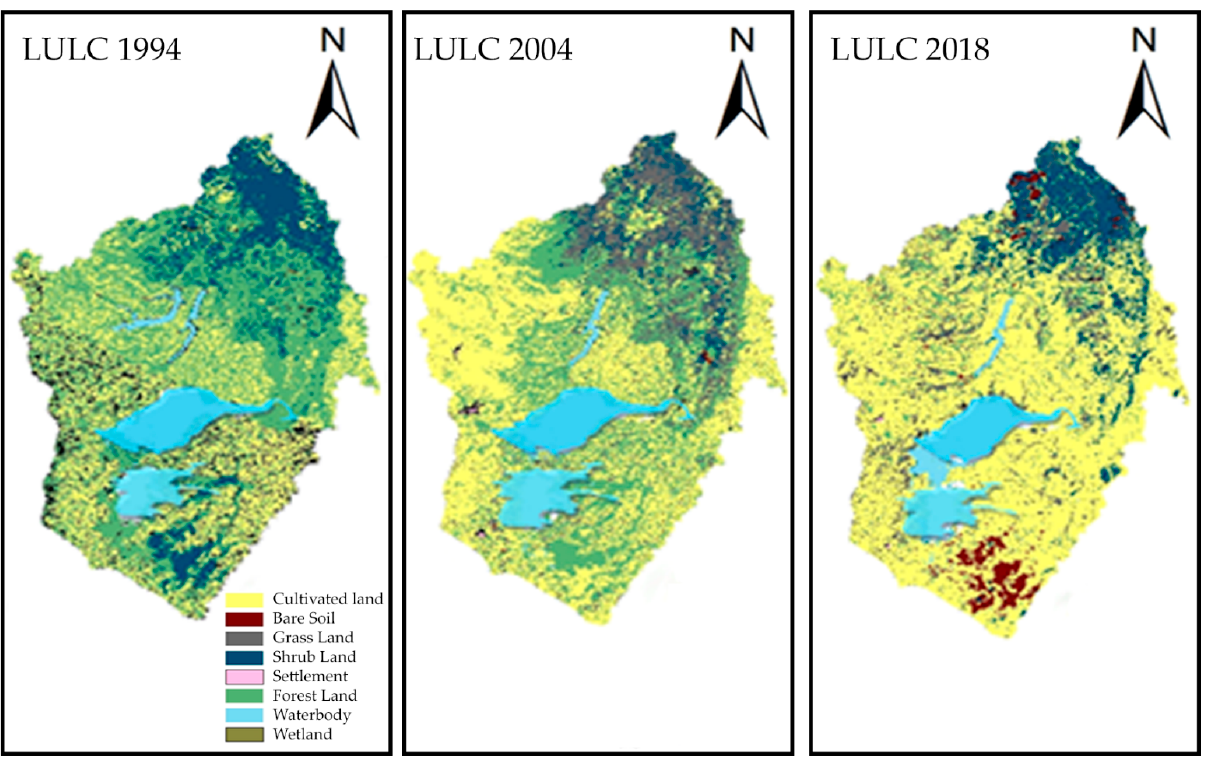
Figure 9. Fincha’a watershed LULC in the three reference years.